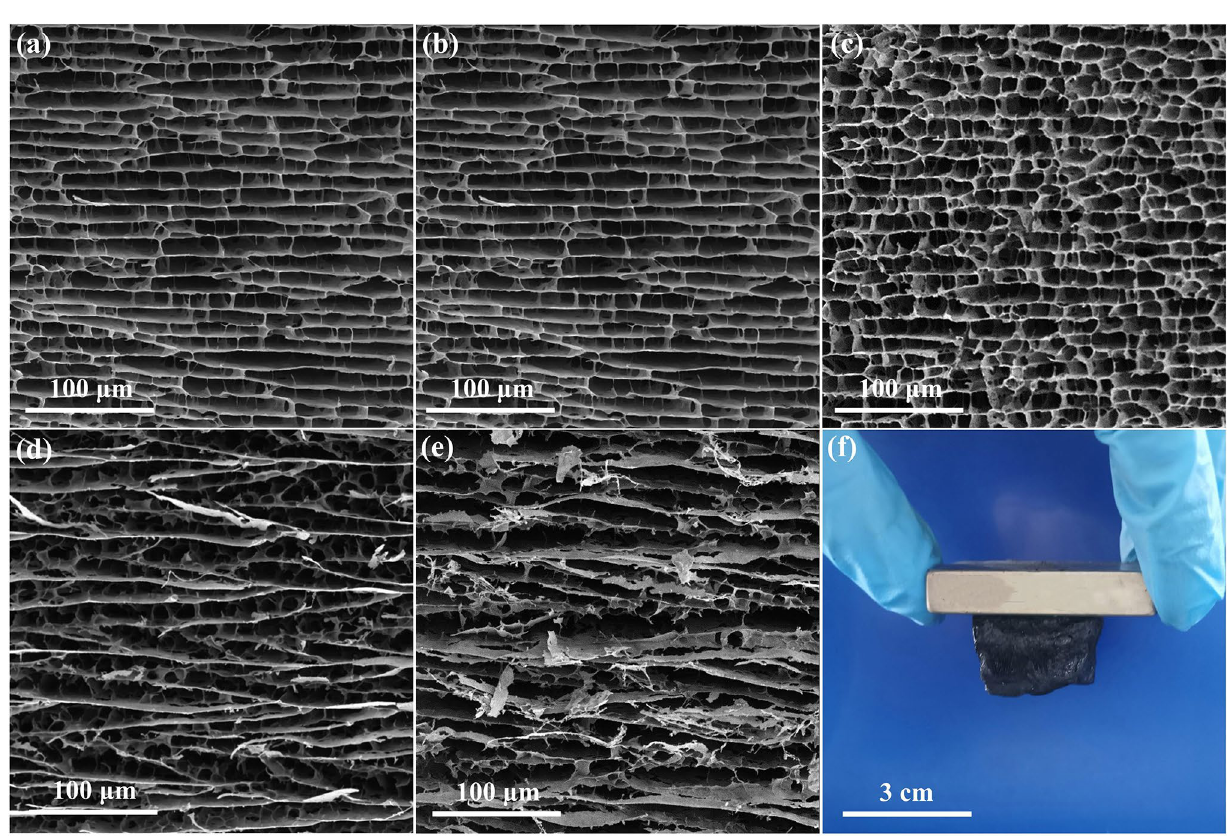
Fig. 3 a SEM images of BTCA, b BTFCA-1, c BTFCA-2, d BTFCA-3 and e BTFCA-4. f Digital photograph of magnet attracting